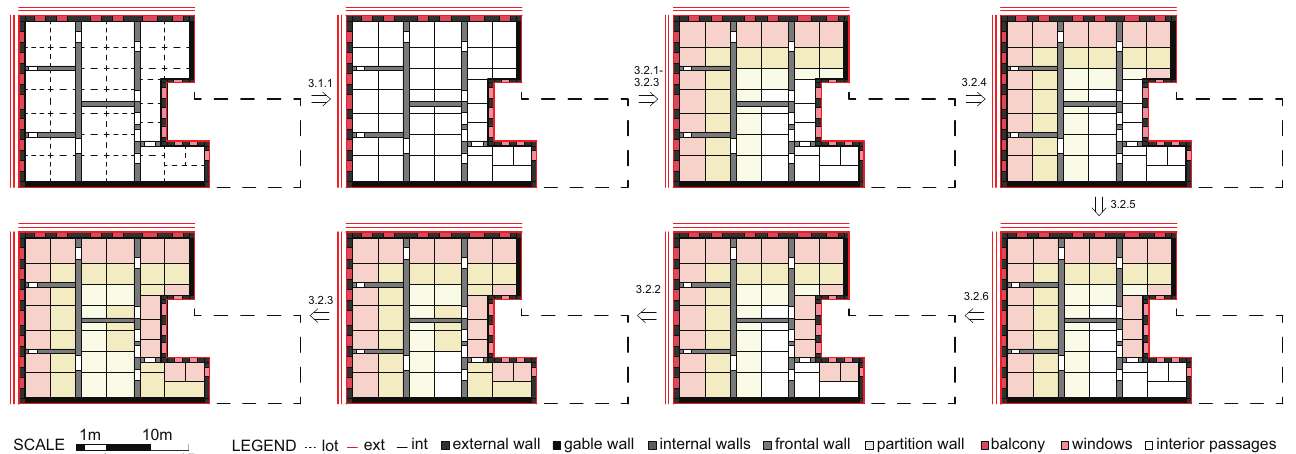
Figure 9. Derivation process considering steps for stage 3 for the case study building